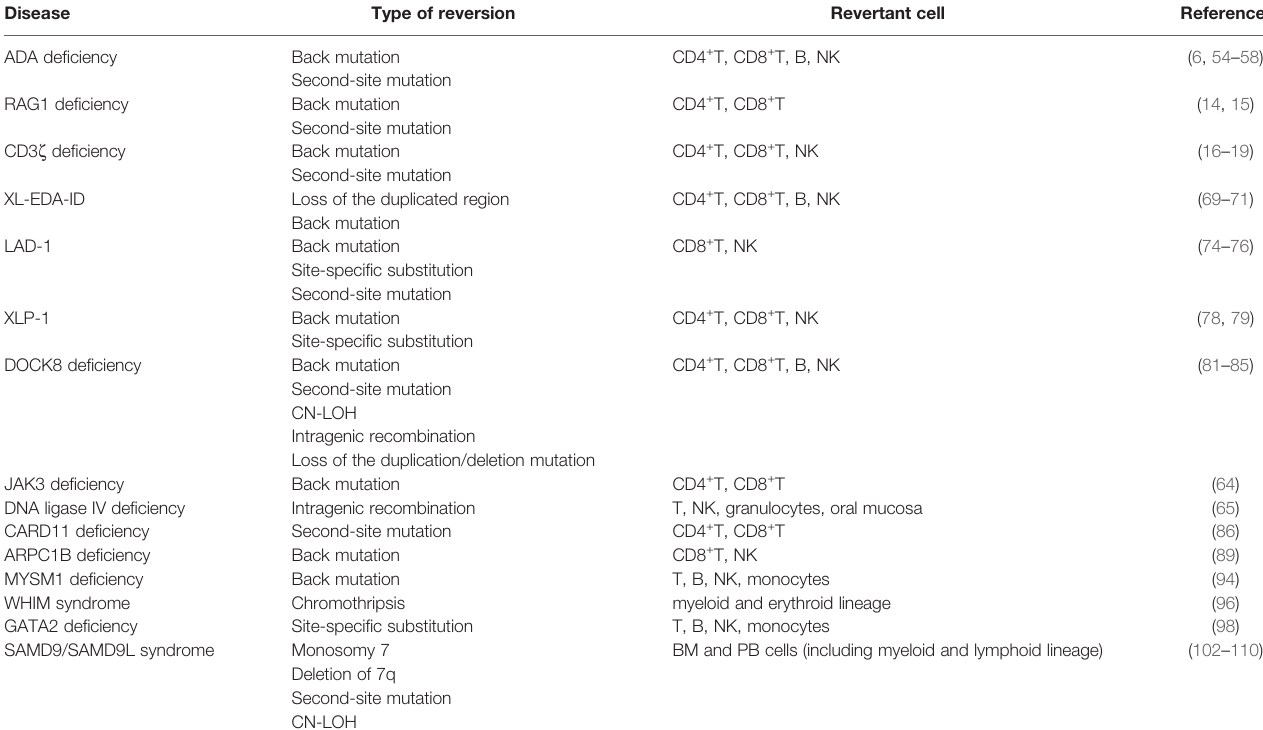
TABLE 3 | Other PIDs in which somatic reversion has been